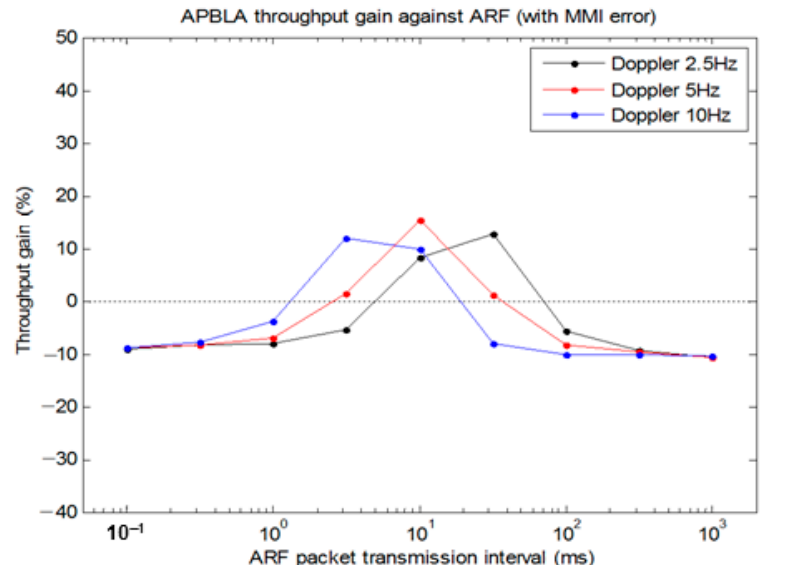
Figure 20. Throughput gain of APBLA relative to ARF as a function of the packet transmission interval over some Doppler frequencies (3-tap channel).